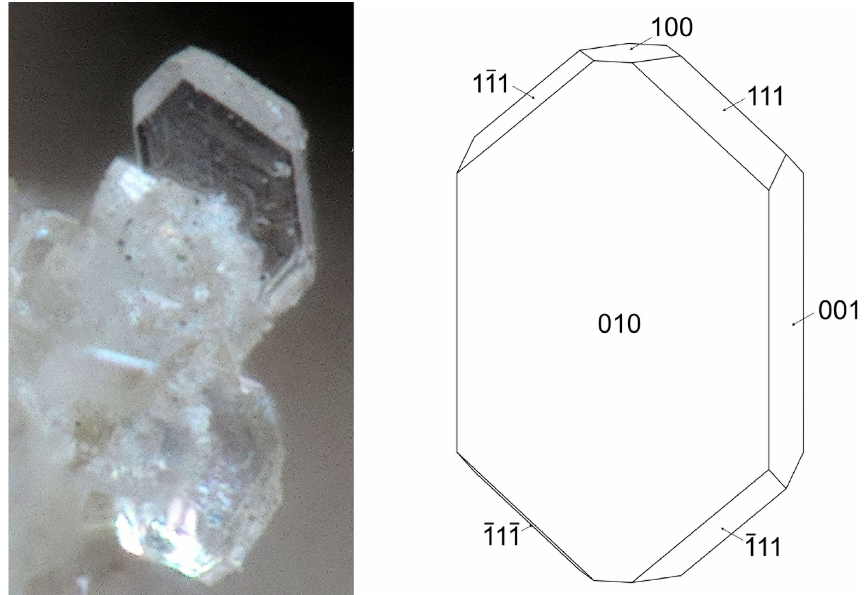
Figure 2. Pleysteinite crystal (photo Christian Rewitzer) with crystal drawing (clinographic projection in nonstandard orientation, a vertical) showing face